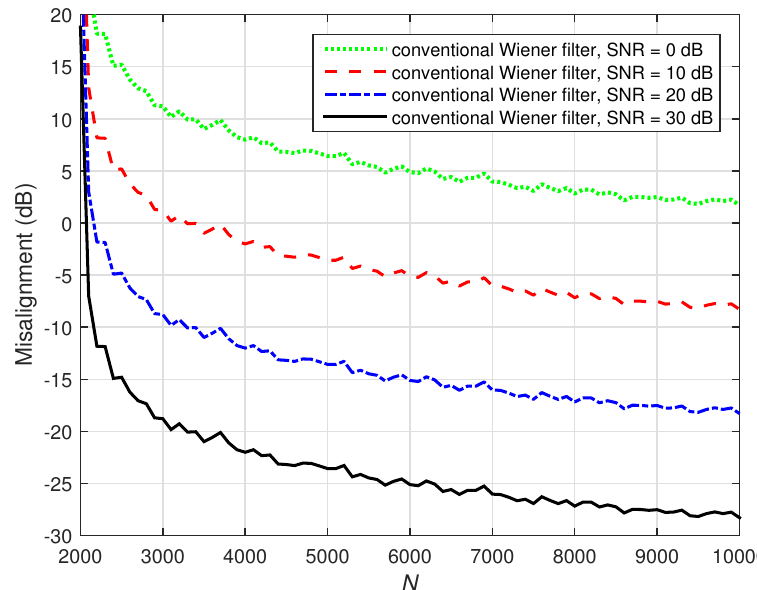
Figure 7. Performance of the conventional Wiener filter for different values of N (number of available data samples to estimate the statistics) and SNRs. The input signals were independent AR(1) processes, M = 4, and L =